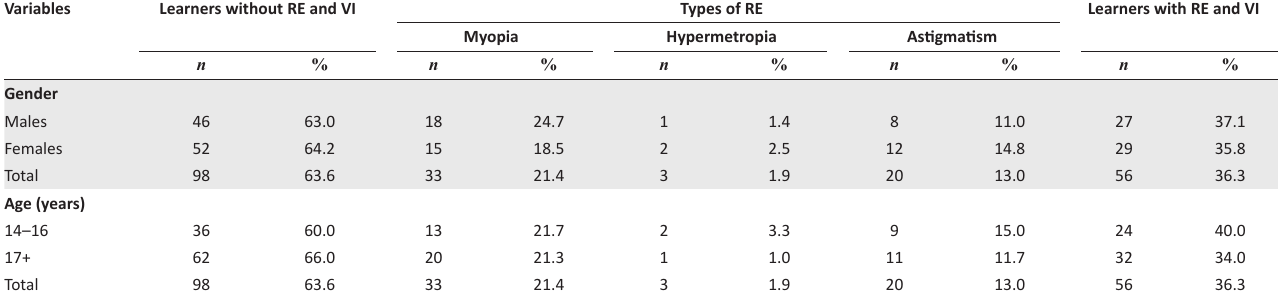
TABLE 2: Participants with and without refractive error (RE) and visual impairment (VI) based on age and gender. Variables